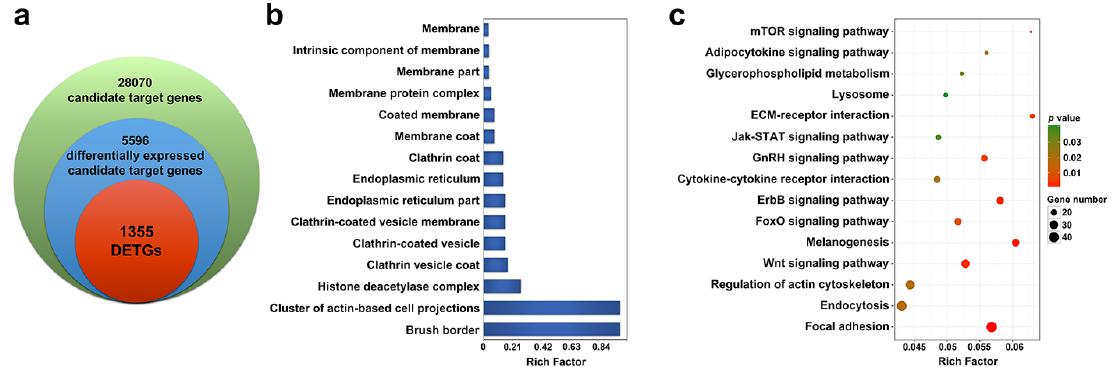
Figure 4. Identification and functional enrichment of the differentially expressed target genes of DEmiRs (DETGs). ( a ) Venn diagram showing the process of DETG identification. Candidate target genes were predicted based on bioinformatics analysis, differentially expressed candidate target genes were identified based on their expression changes in response to Vibrio anguillarum infection, and DETGs were identified based on the integrative analysis of miRNA-mRNA expressions. ( b ) Gene Ontology ( GO) enrichment of DETGs. ( c ) Kyoto Encyclopedia of Genes and Genomes (KEGG) enrichment of DETGs.